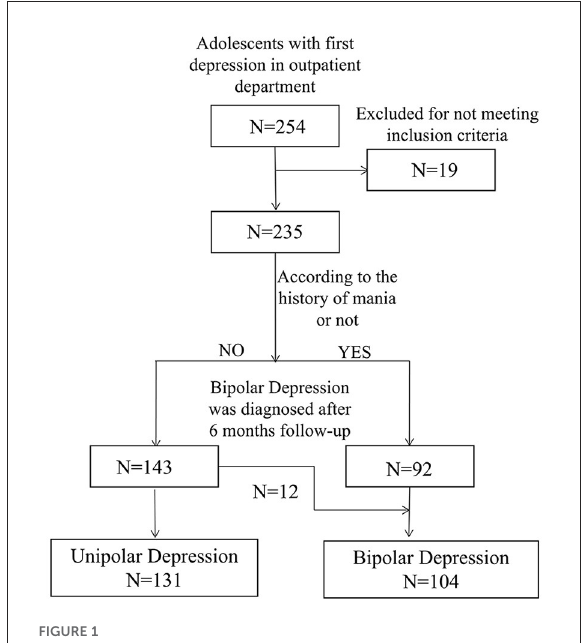
FIGURE1 Flow chart of study